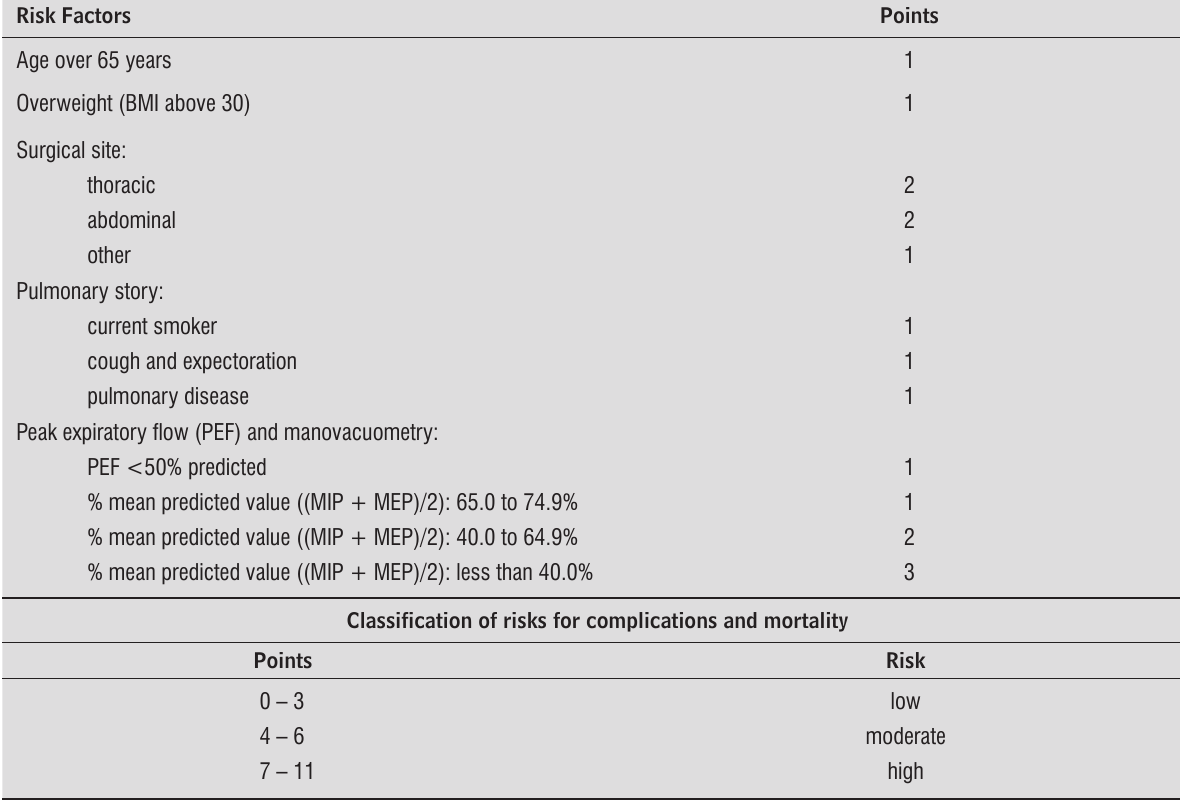
Table 1 - Classification of the risk for PPC, based on the Torrington and Henderson scale (TH) with modifications, replacing spirometry by PEF and manovacuometry Risk Factors Points Age over 65 years 1 Overweight (BMI above